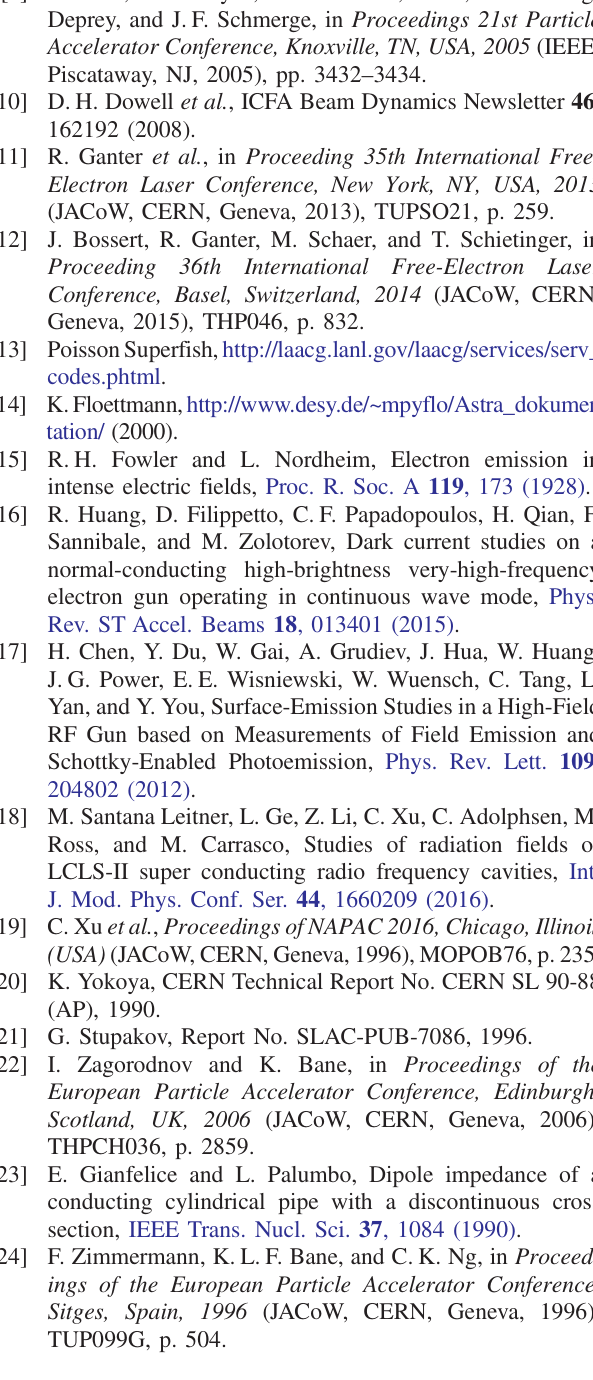
Correction: Part of the image in the original Figure 7 contained an error and its replacement has been